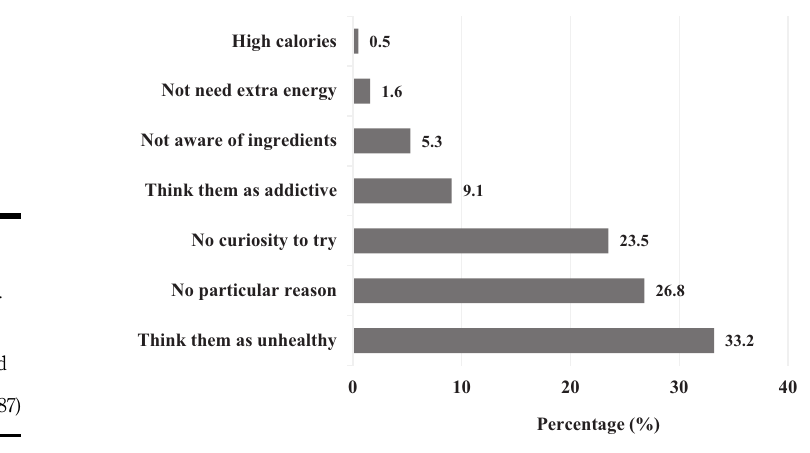
Figure 2. Common reasons for not using energy drinks among participants who had never consumed energydrinks( n 5